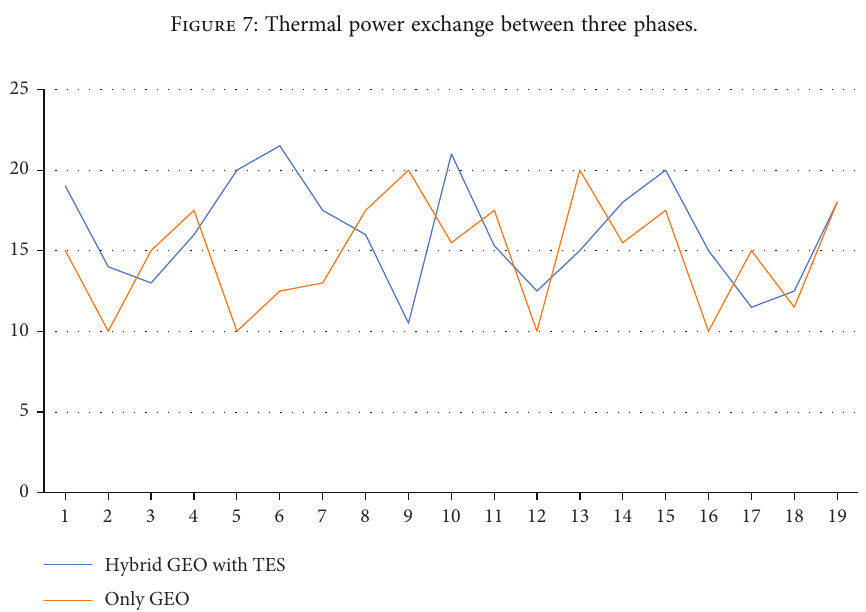
Figure 8: Geothermal power with and without thermal